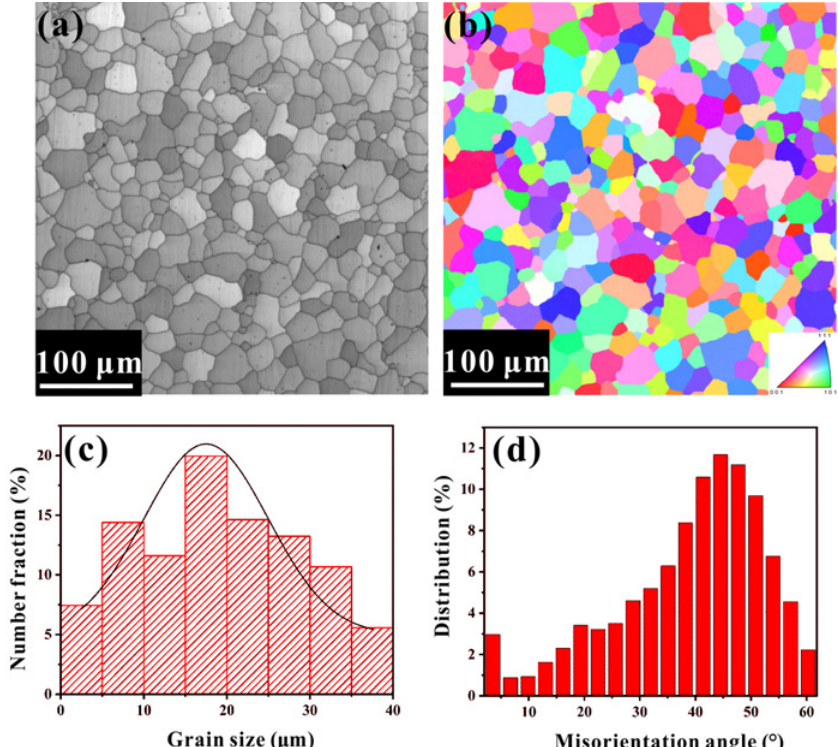
Fig. 4 (a) SEM image, (b) EBSD mapping, (c) grain size distribution, and (d) grain boundary misorientation angle distributions of high-entropy (TiVNbMoW)C 4.375